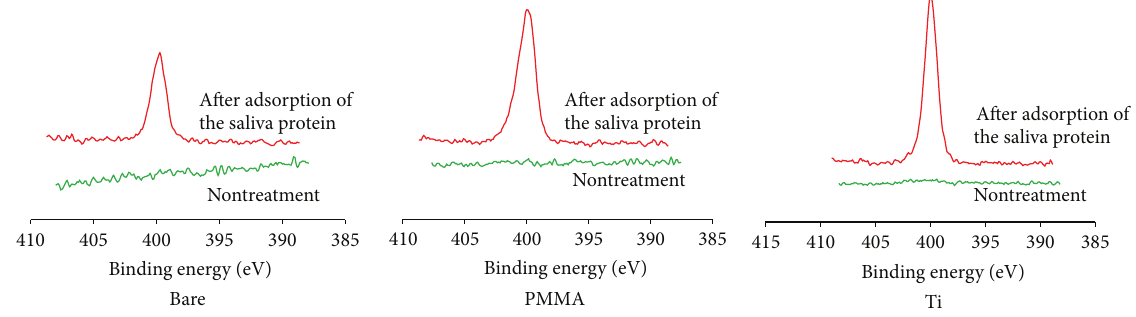
Figure 9: XPS analysis after adsorption of BSA. N1s XPS spectra for BSA adsorbed onto bare, PMMA, and Ti QCM sensors. N1s XPS spectra before (green) and after adsorption (red) for BSA.